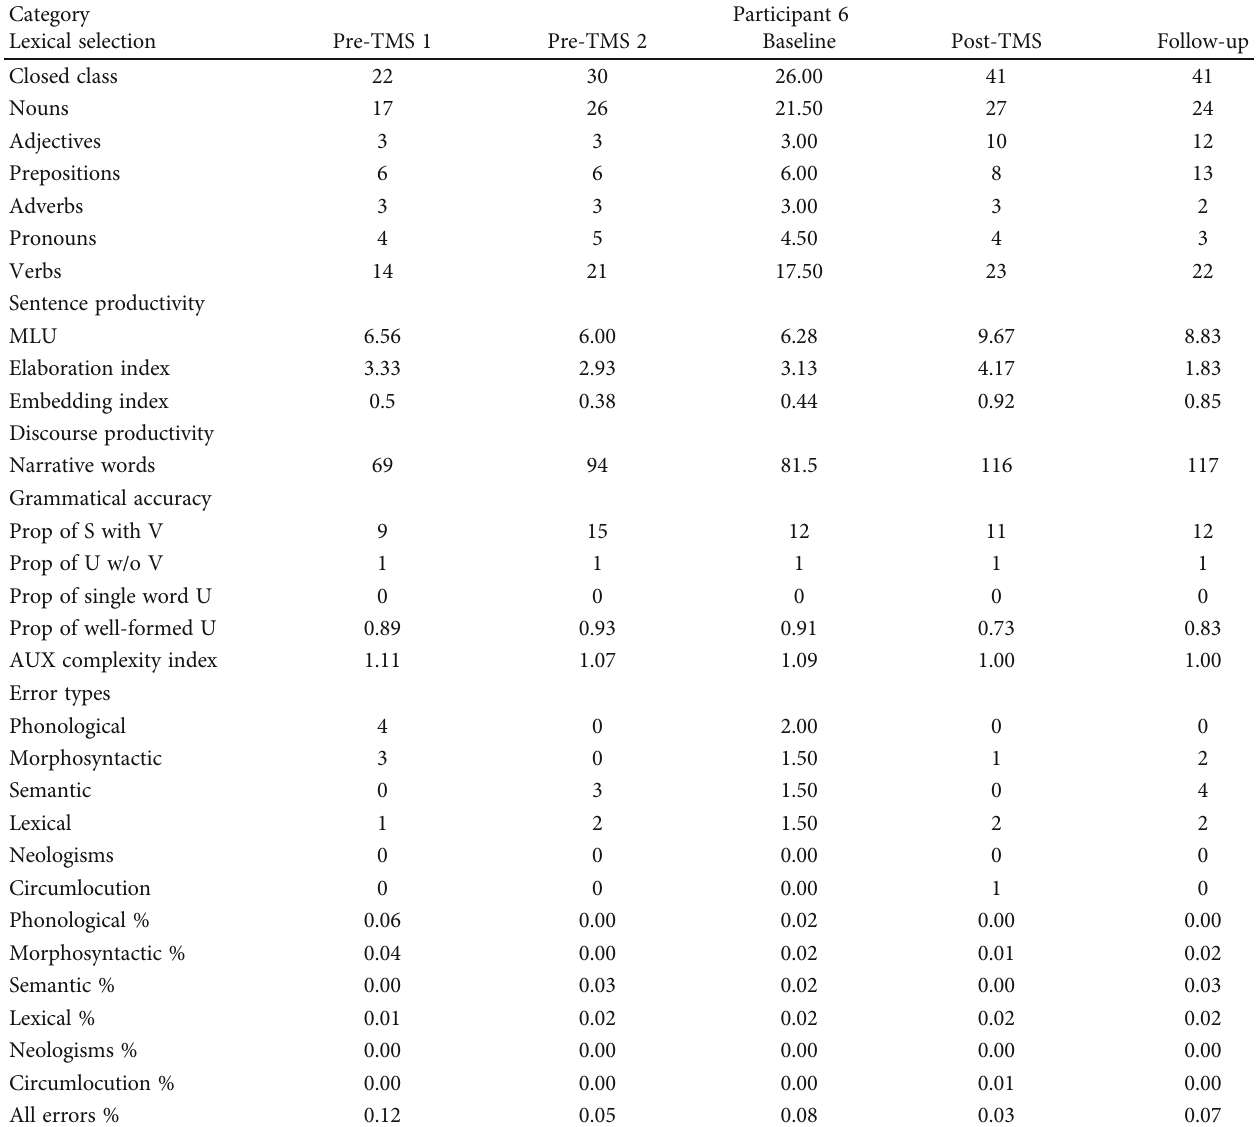
Table 7: Short-term (one day posttreatment) and long-term (two months posttreatment) e ff ects of 1Hz rTMS on narration outcomes (i.e., functional communication) for participant